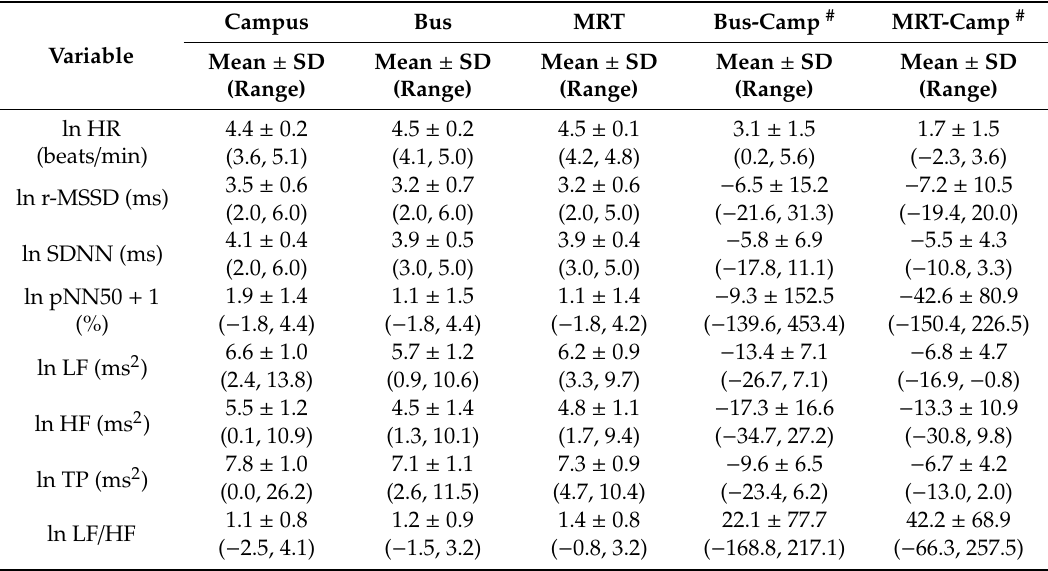
Table 1. Summary statistics of heart rate variability indices for the participants in di ff erent